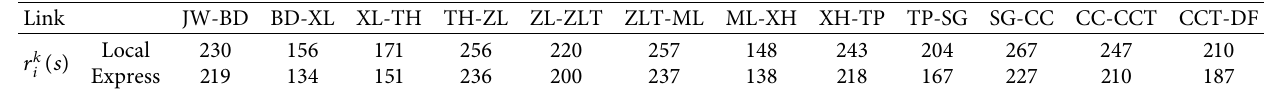
Table 4: Original train dwelling time at different stations.